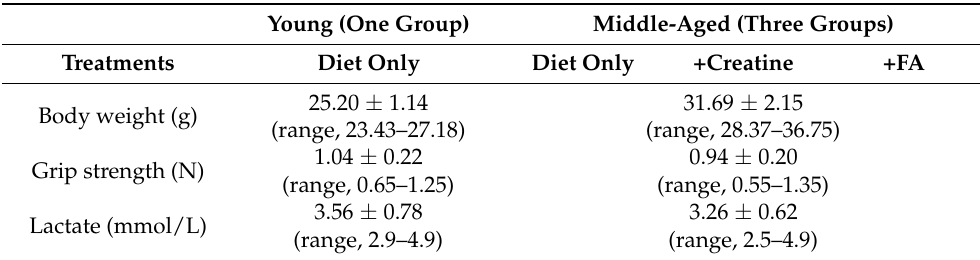
Table 1. Initial body weight, grip strength and lactate level in experimental groups. Young (One